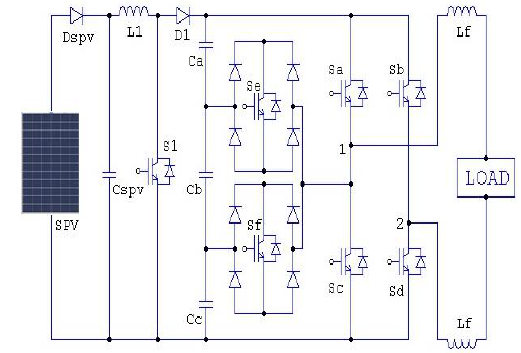
Figure 5. Proposed 1 ∅ Seven Level Cascaded H-Bridge MLI for SPV